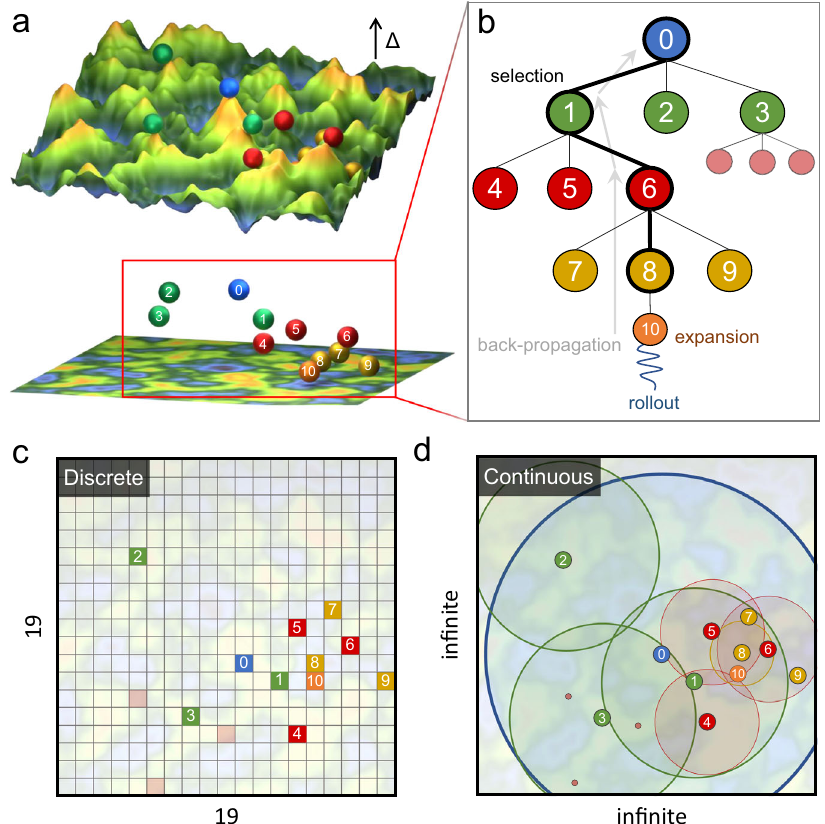
Fig. 1 Schematic of the continuous action MCTS algorithm applied for exploration of high-dimensional potential parameter surfaces. a Top: Simplistic representation of an objective landscape for a two-parameter search problem. In-plane axes correspond to (two) independent model parameters. The out- of-plane axis corresponds to objective values, which is de fi ned as the weighted sum of the error in model predicted energies of clusters with respect to target energies. This objective is minimized by our c-MCTS algorithm. The spheres represent candidates of different model parameters within an MCTS run, where differences in their vertical positions indicate differences in their objective values. Bottom: Slightly tilted view of the above with the surface represented as a contour map below the spheres. The numbering on the spheres corresponds to their node positions in the MCTS tree shown in b . These numbers roughly correspond to the order that the candidates are explored. b Schematic showing the root, parent, child nodes, and their relationship within an MCTS tree structure. A typical MCTS search involves node selection, expansion, simulation (playout), and back-propagation. Different coloring of the nodes indicates different depths in the MCTS tree. The algorithm balances between exploration (lateral expansion of nodes) and exploitation (depth expansion of nodes). As shown in a , the objective value of an MCTS run is expected to decrease quickly along with the depth of the tree. c Search space of a traditional MCTS algorithm, e.g., game board, is discrete. In the context of parameter optimization, for two discrete parameters each of 19 possible values, the search space consists of a fi nite 361 search positions. d The problem of parameter search, such as the objective surface illustrated in a , generally involves parameters that are continuous, which corresponds to in fi nite possible search positions. We handle this challenge by applying a range-funneling technique to the MCTS algorithm where the search neighborhood at each tree-depth becomes smaller and smaller such that the algorithm can converge to the optimal